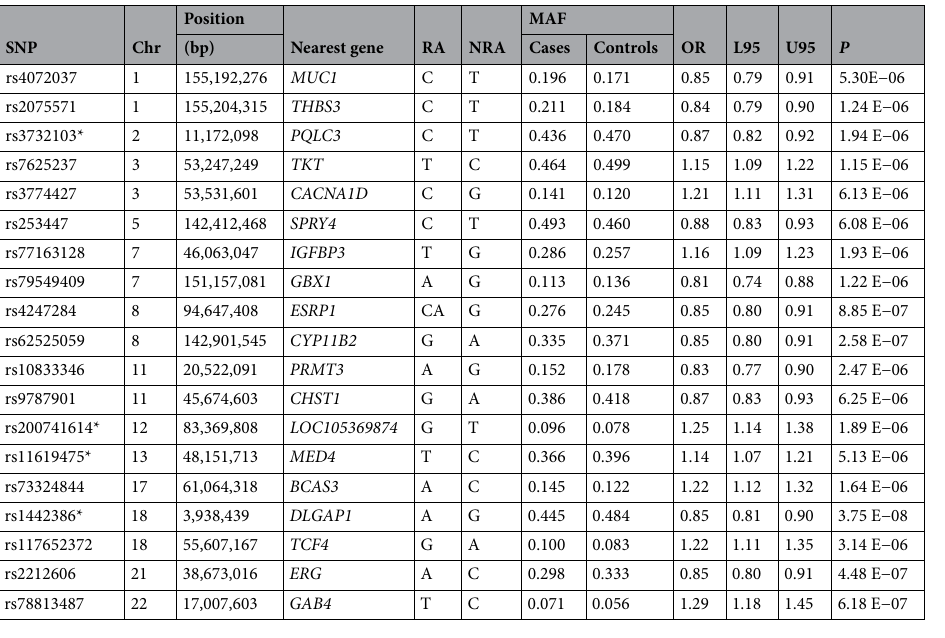
Table 1. Summary of association results of genome-wide association study in Japanese population. SNP single-nucleotide polymorphism (rsID of lead SNP); Chr chromosome, position, physical position of human genome version of GRCh38; RA risk allele, NRA non-risk allele, OR odds ratio, L95 lower 95% confidence limit, U95 upper 95% confidence limit, MAF minor allele frequency. Odds ratios (OR) and confidence intervals (CI) were calculated using the non-risk allele as a reference. *:Indicates a novel locus for resistant hypertension. The nearest gene is shown as the locus label, but should not be interpreted as the best candidate. A list of all the genes in the 500-kb flanking region of the lead SNP is presented in Table